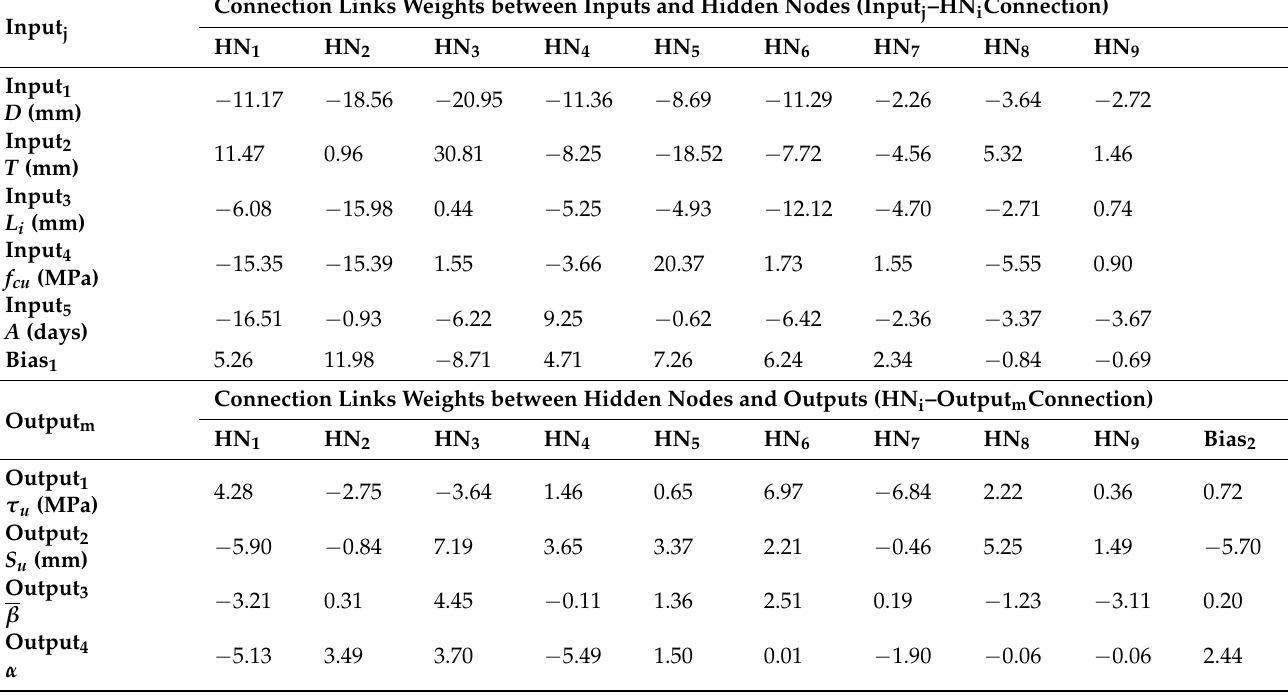
Table 3. Connection links weight used in 5-9-4 ANN1.